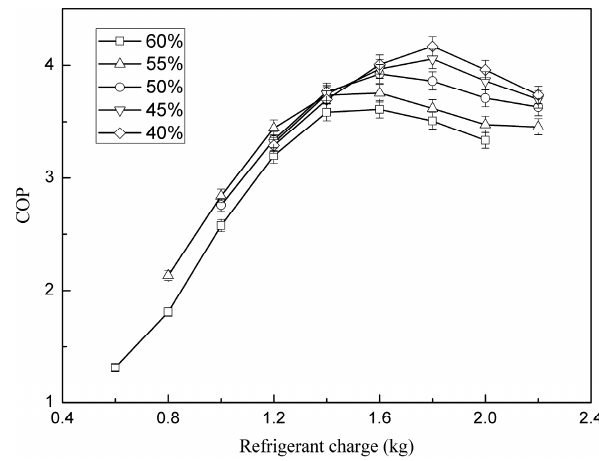
Figure 10. Variations of COP with refrigerant charge and EEV opening.